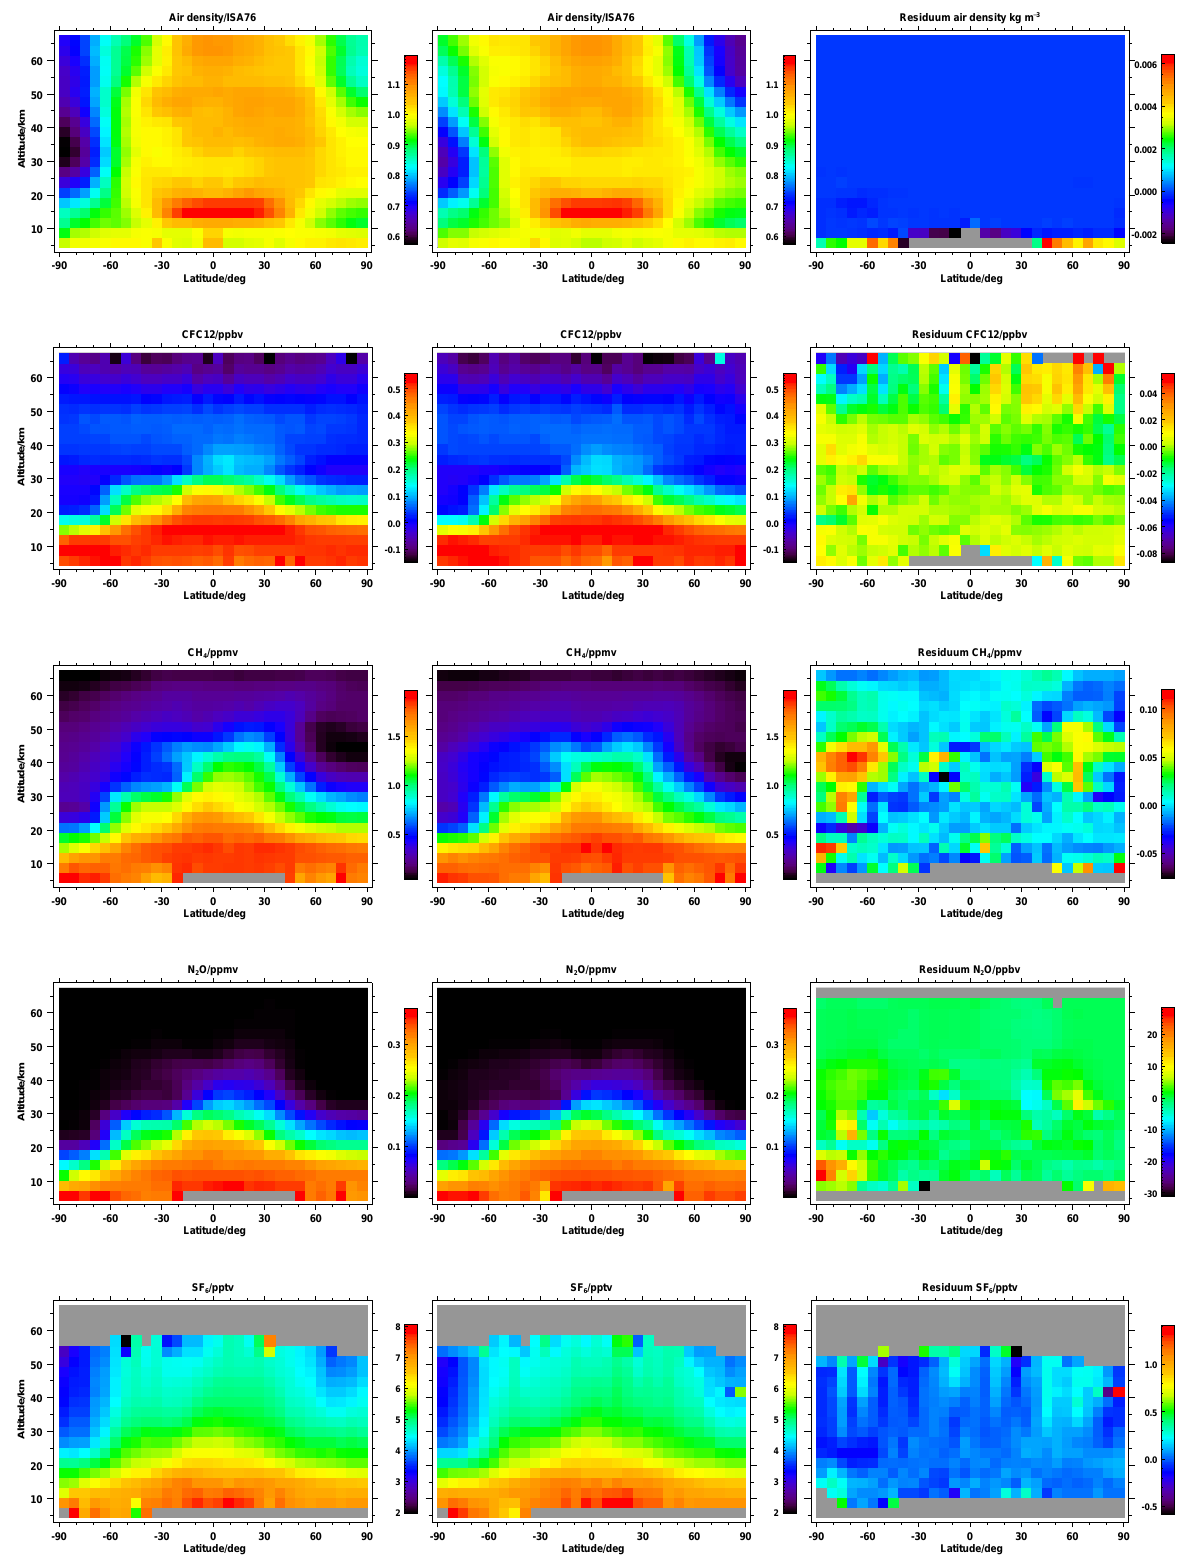
Figure 3. Measured distributions in September (left column) and October (middle column) and residual distributions between October measurements and predictions for October (right column) for air density and mixing ratios of CFC-12, CH 4 , N 2 O, and SF 6 (top to bottom). Grey grid boxes indicate nonavailability of valid